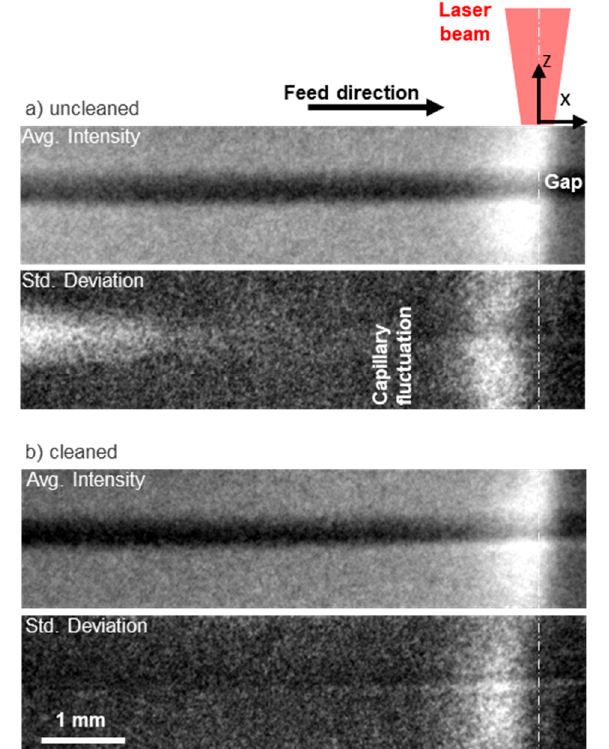
Figure 5. Distribution of the standard deviation (std. deviation) of the greyscale of the X-ray videos of welds welded with a feed rate of 6 m/min, a beam diameter of about 500 µm, and a laser power of 4.5 kW in overlap configuration of uncleaned sheets, ( a , and sheets cleaned by etching, b ). Avg. intensity refers to the average intensity in both cases.